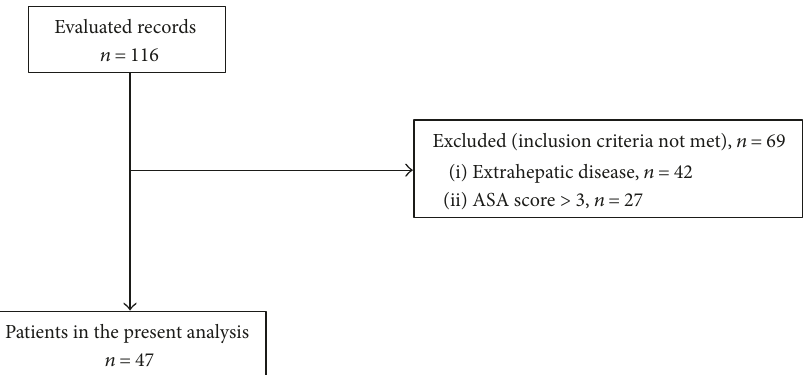
Figure 1: Patients included in the